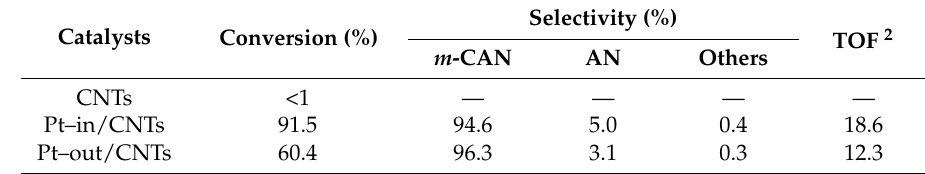
Table 2. In-situ hydrogenation of m -CNB over CNTs, Pt–in/CNTs, and Pt–out/CNTs. 1.